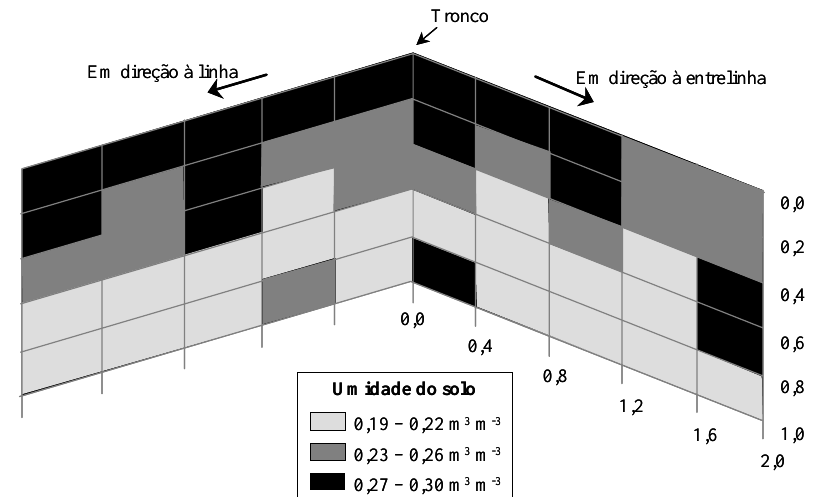
Figura 2. Perfis de umidade ( qqqqq versus z) para as várias distâncias do tronco, em direção à linha e em direção à entrelinha durante o período chuvoso.